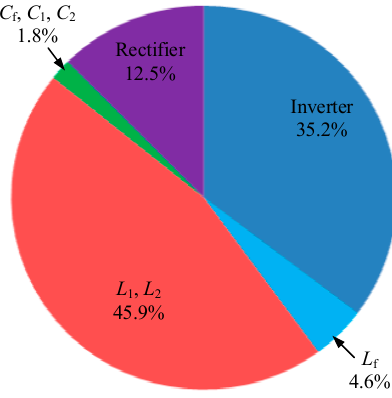
Figure 10. Power losses distributions when U in = 183 V, U bat = 200 V.